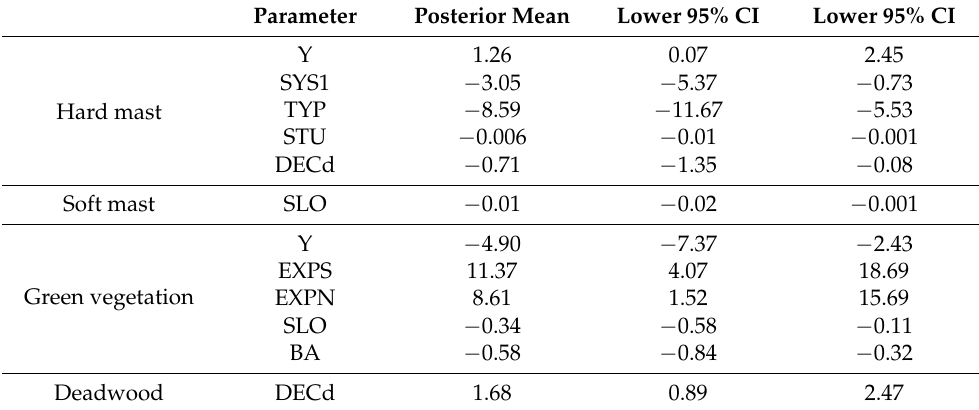
Table 5. Estimates of posterior mean parameter and their 95% credible intervals describing the effect of structural and topographic variables on abundance of plant-based food for Apennine brown bear and amount of deadwood (proxy for ant occurrence). Reference class of categorical variables: beech forest type (TYP = 1), high forests (SYS = 0), eastern aspect (EXP = E). Only parameters for which the coefficients were significant (i.e., credibility intervals did not contain the zero value) are